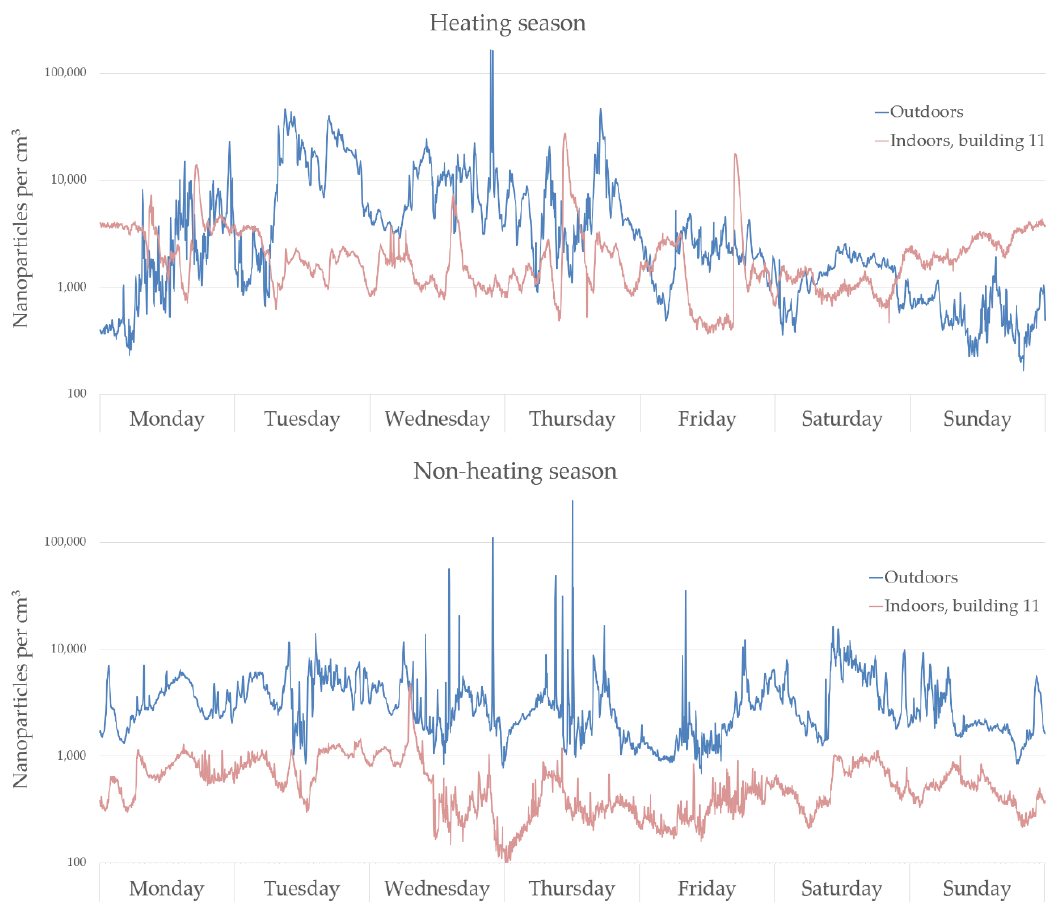
Figure 4. The weekly variations in nanoparticle concentrations indoors in Building 11 and outdoors during heating and non ‐ heating seasons presented on a logarithmic scale.